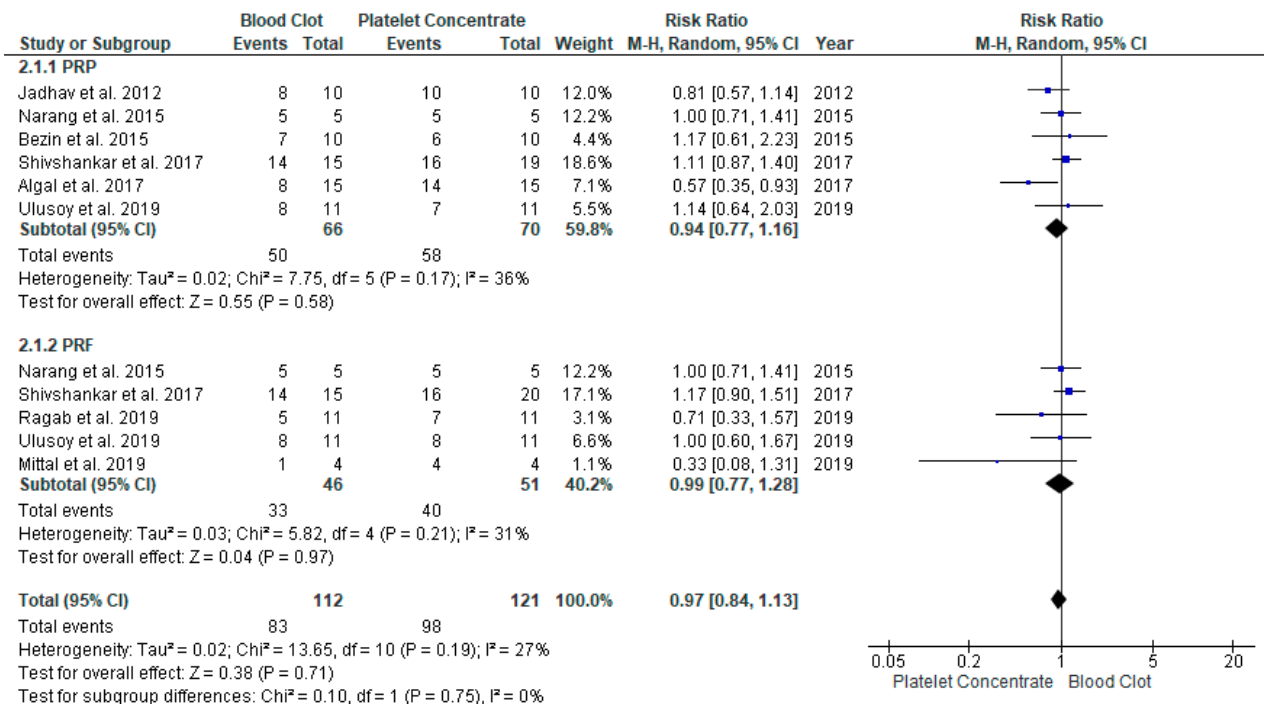
Figure 6. Meta-analysis of apical foramen width (AFW) in regenerative endodontic procedure (REP) using APC or BC.